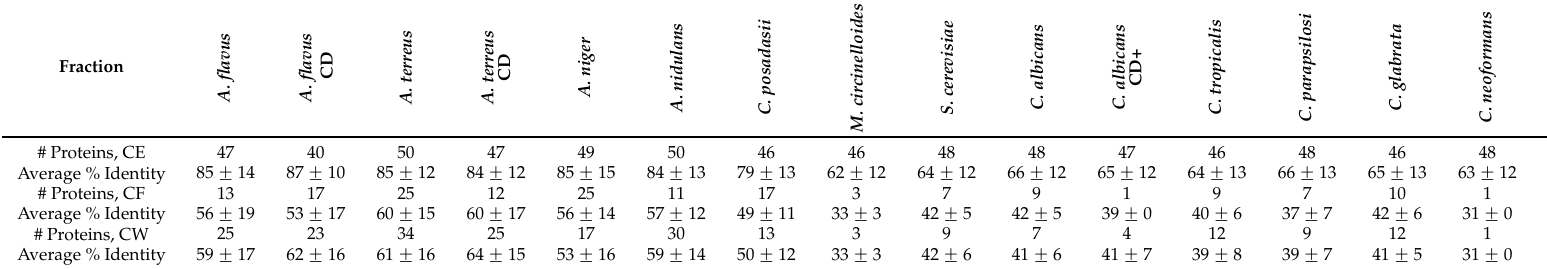
Table 2. Homology comparisons for the 50 most abundant CE proteins and all SSL proteins of Aspergillus fumigatus *.